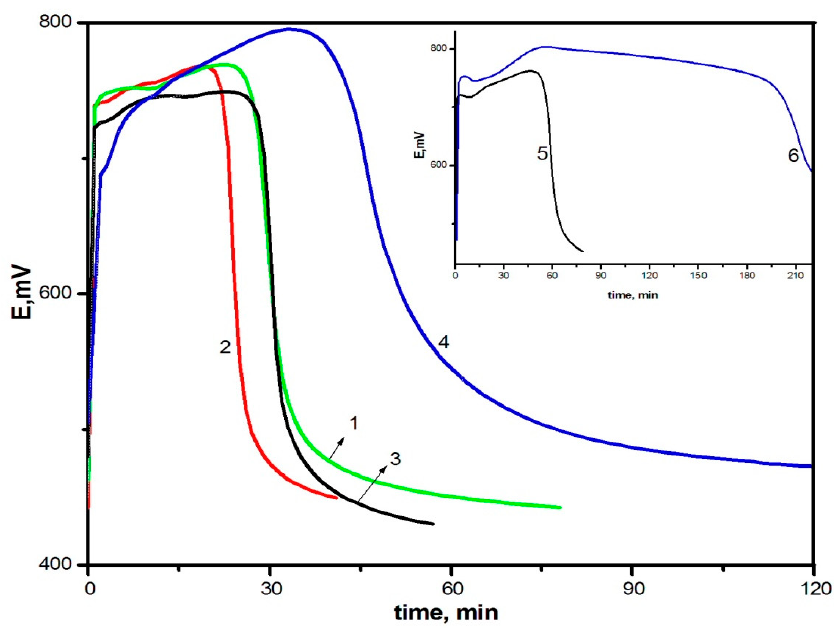
Figure 3. Changes in redox potential with time at the oxidation of DADCB: [Ox]/[DADCB] = 0.75 (1), 1.25 (2), 1.75 (3), 2.5 (4), and at the oxidation of aniline: [Ox]/[An] = 1.25 (5), 2.5